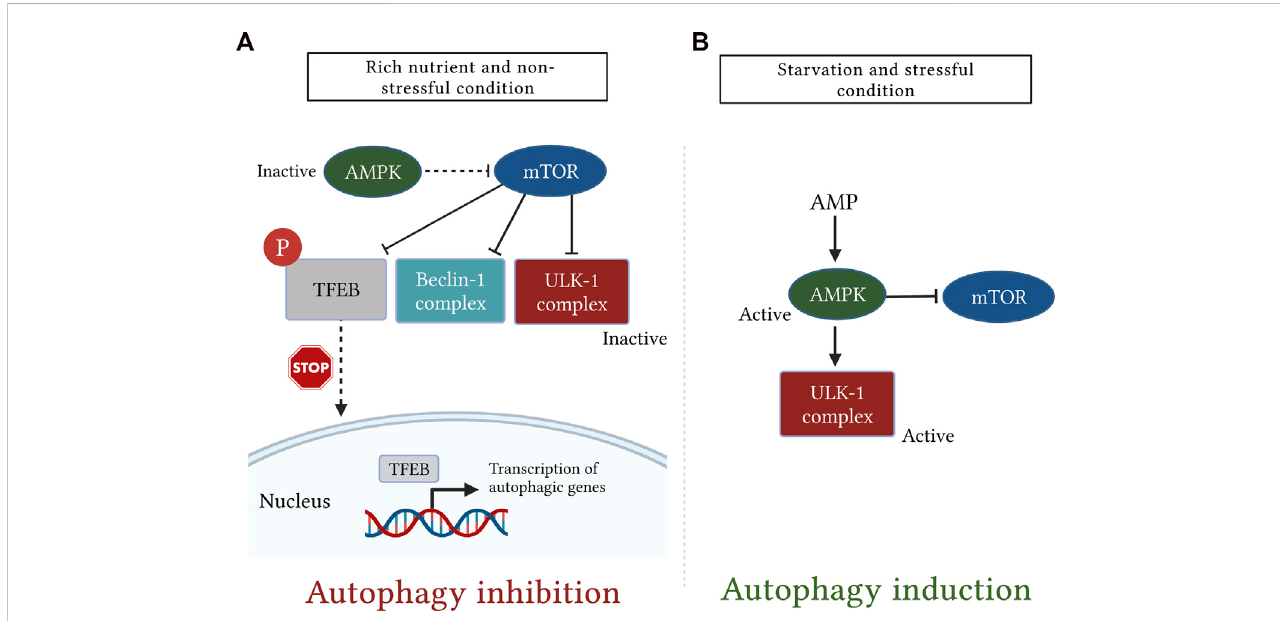
FIGURE 5 Asimplisticdiagramshowingtheantagonisticroleofthemechanistictargetofrapamycin(mTOR)andAMP-activatedproteinkinase(AMPK)inregulation of mammalian autophagy. The cellular energy status is closely monitored by the two kinases, mTOR and AMPK. (A) : under rich nutrient state and absence of environmentalstress,mTORisactivatedandsuppressesautophagybydisruptingtheactivation ofUnc51-likekinase(ULK1)andBcl-2-interacting myosin-like coiled-coil protein (Beclin-1) complexes. mTOR also inhibits autophagy by phosphorylating transcription factor EB (TFEB), which, in turn, sequesters TFEB in the cytosol and prevents it from being translocated into the nucleus. (B) : Conversely, following starvation or stress response, AMPK is activated and induces autophagy either by direct phosphorylation of ULK1 or indirectly through downregulation of mTOR